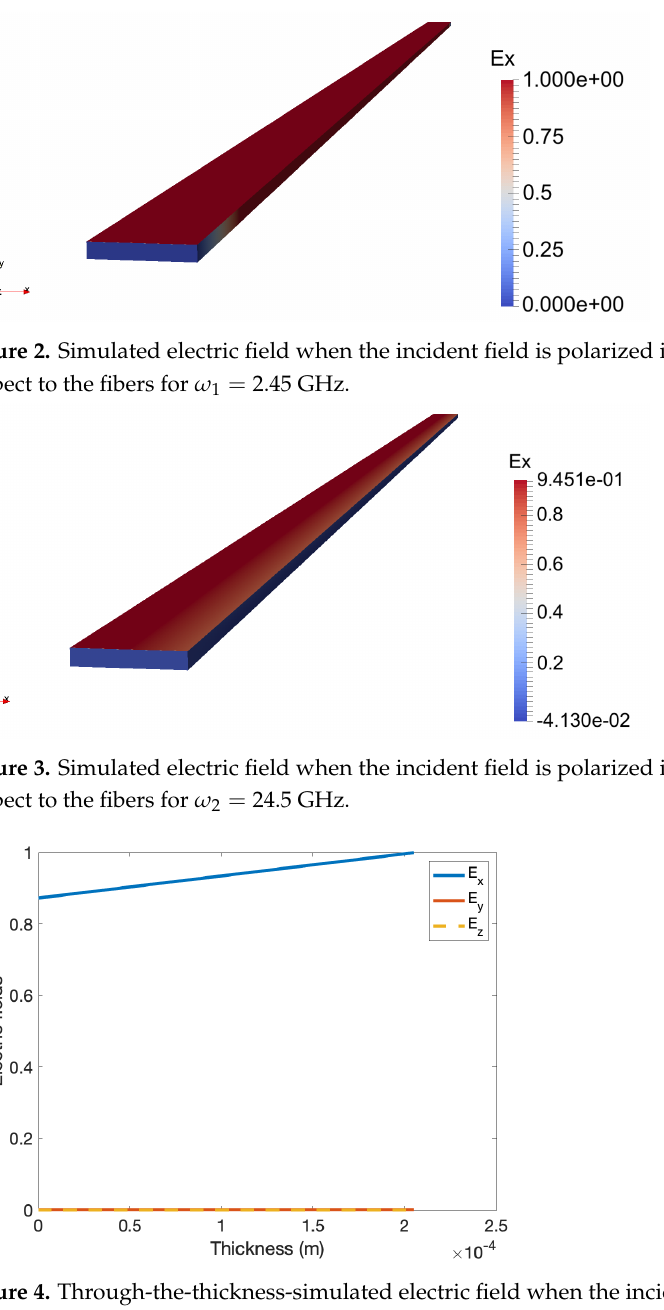
Figure 4. Through-the-thickness-simulated electric field when the incident field is polarized in the normal direction with respect to the fibers for ω 1 = 2.45